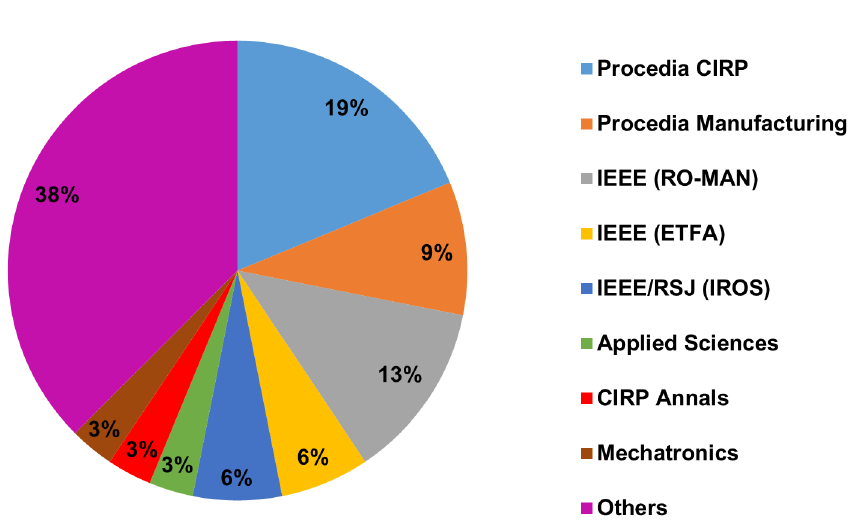
Figure 6. Publication venues.